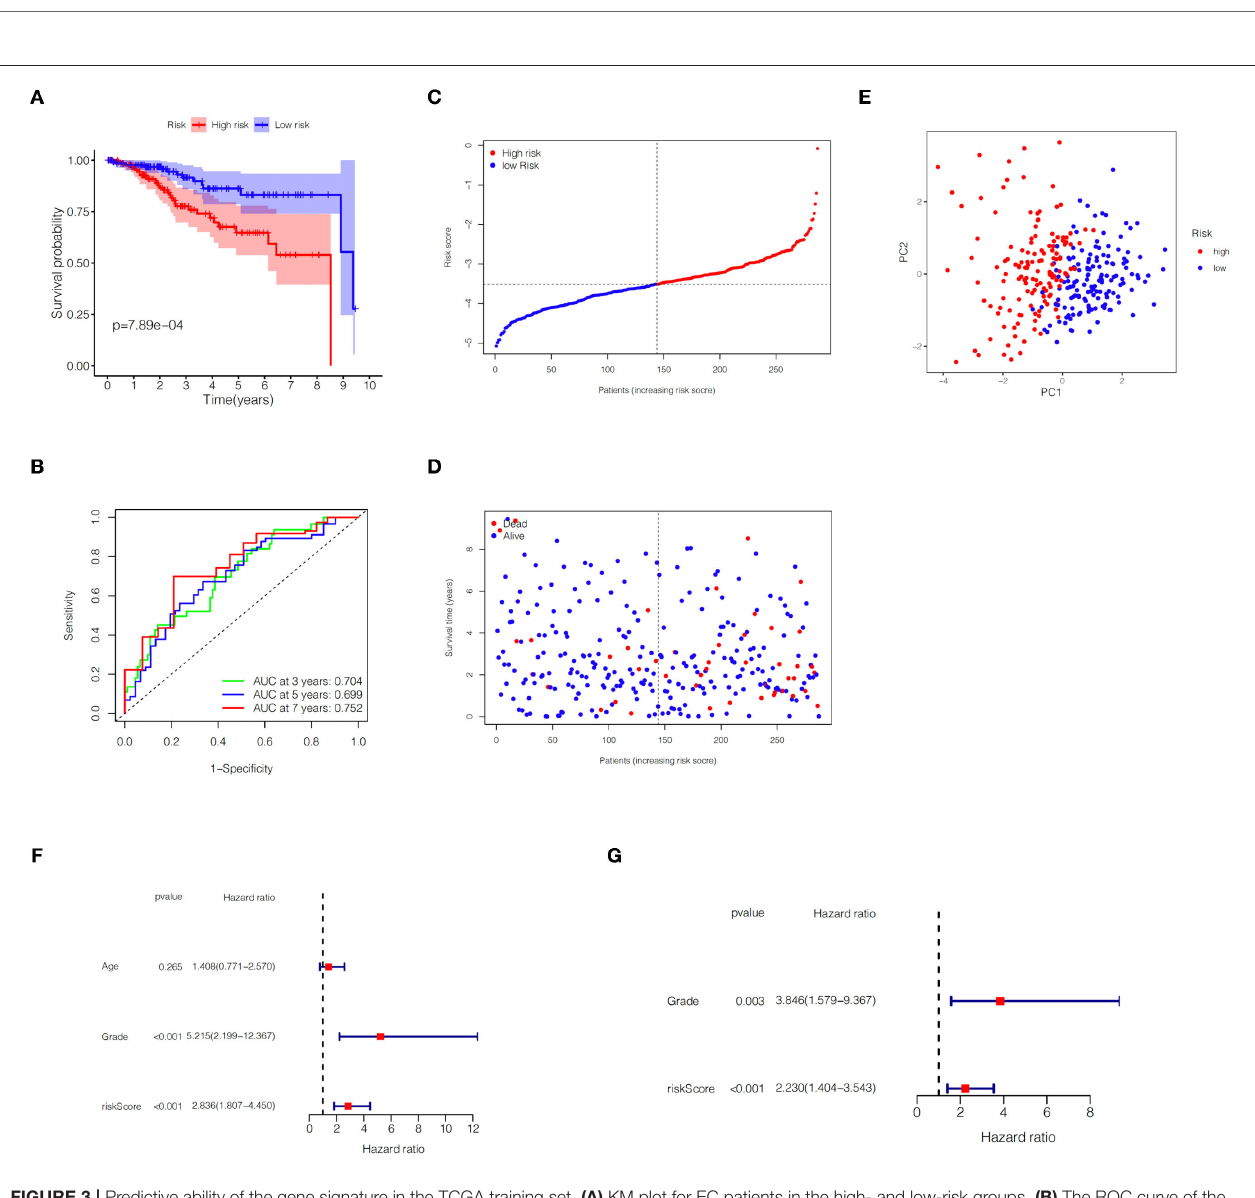
FIGURE 3 | Predictive ability of the gene signature in the TCGA training set. (A) KM plot for EC patients in the high- and low-risk groups. (B) The ROC curve of the gene signature. (C) Distribution of risk scores for EC patients. (D) Distribution of survival time with different risk scores. (E) PCA analysis for EC patients. (F,G) Univariate and multivariate Cox regression analysis of